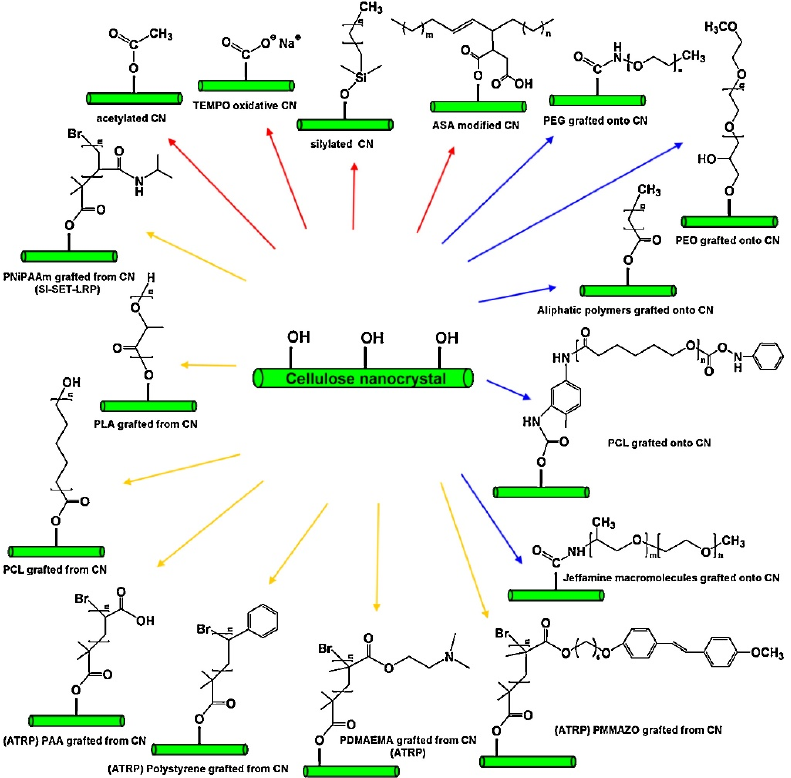
Figure 9. Popular modifications of cellulose nanocrystals (reproduced with copyright permission from Dufresne et al. [196]).